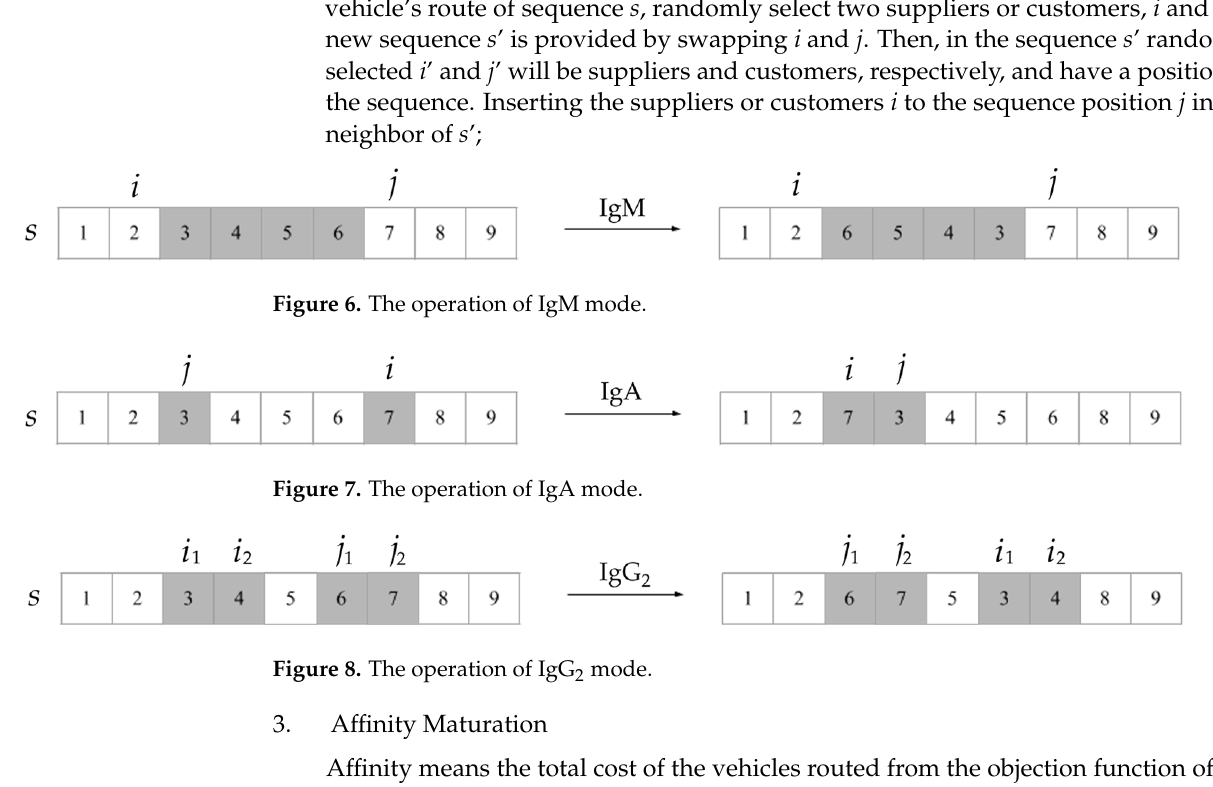
Figure 6. The operation of IgM mode.